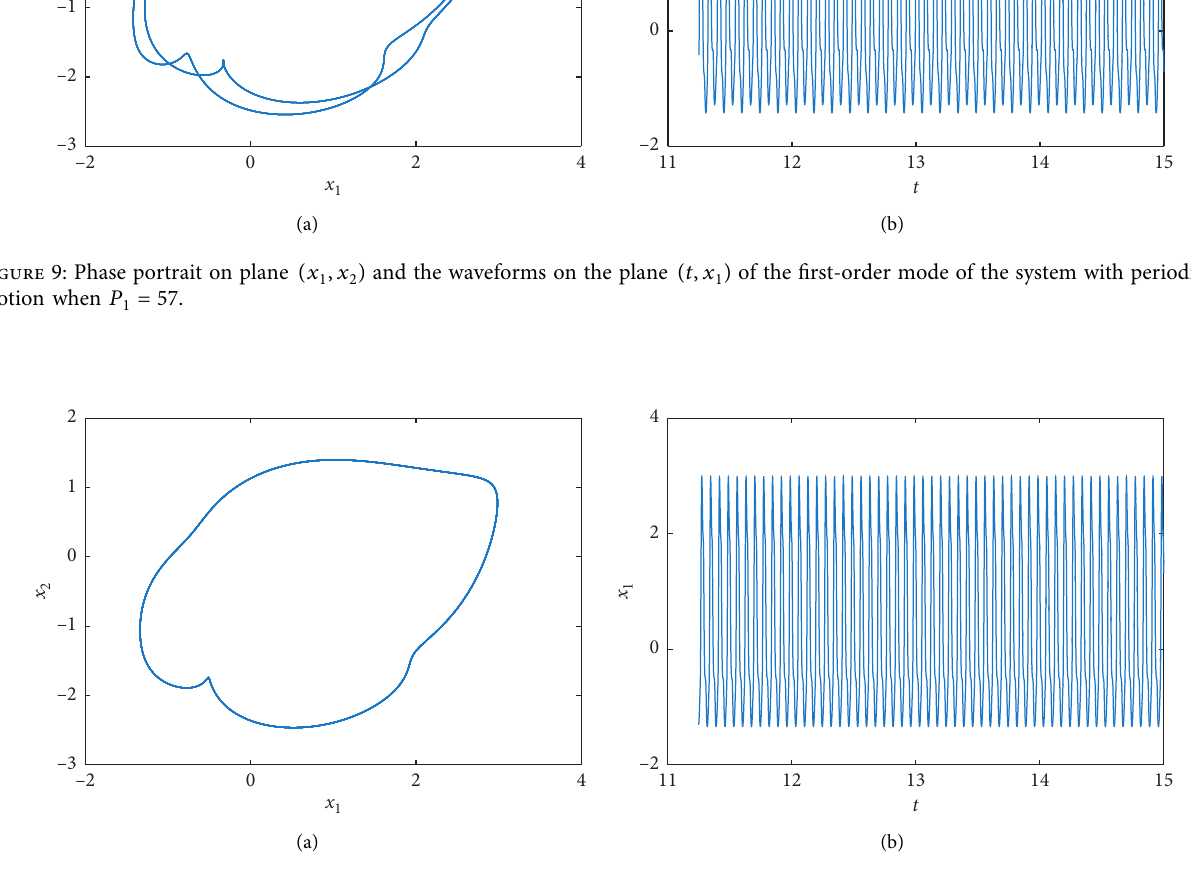
, x ) and the waveforms on the plane ( t, x 1 2